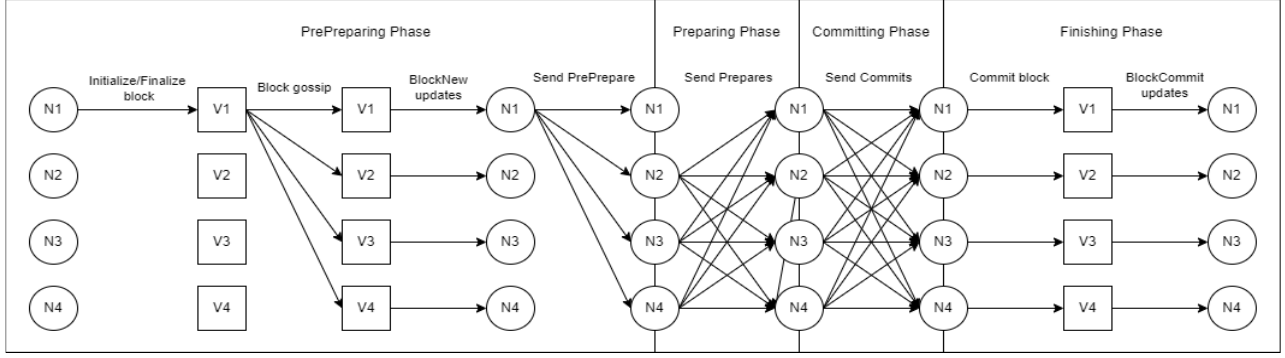
Figure 22. Hyperledger Sawtooth PBFT algorithm